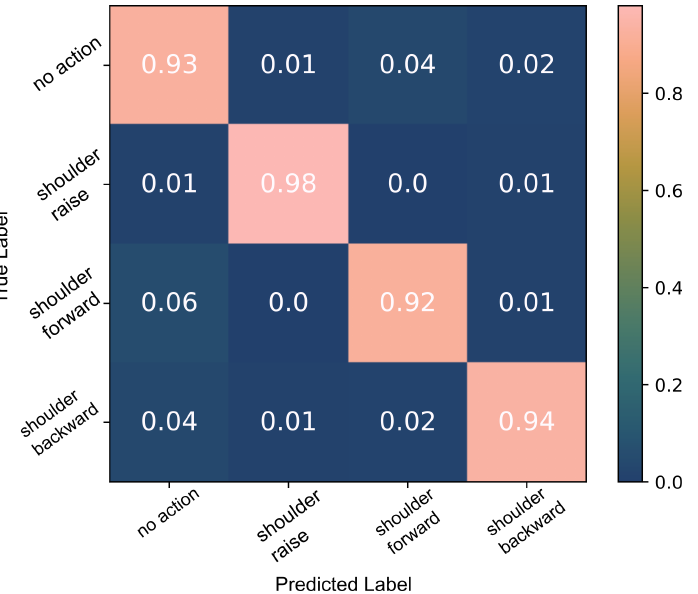
Figure 9. Classification of the three shoulder movements: the 10-fold cross-validation results of the decision tree algorithm which was trained using all able-bodied participants’